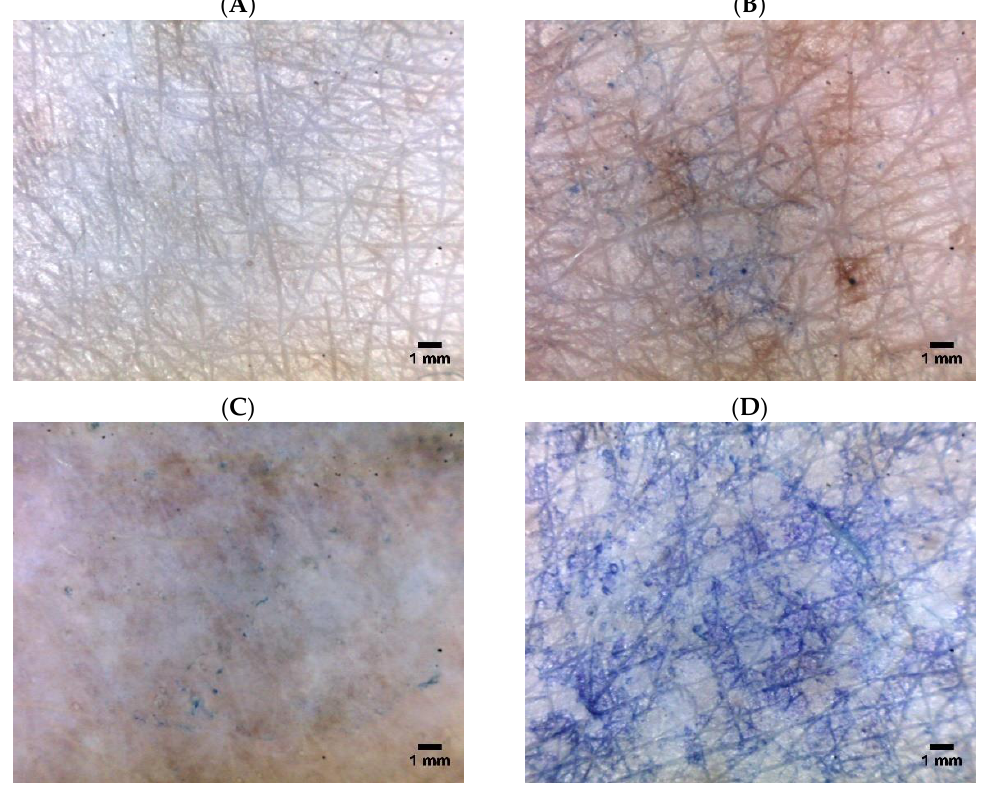
Figure 2. Microscopic images of ( A ) untreated dermatomed human skin and skin treated by ( B ) anodal ITP, ( C ) cathodal ITP, and ( D ) LFS. ITP, ( C ) cathodal ITP, and ( D )